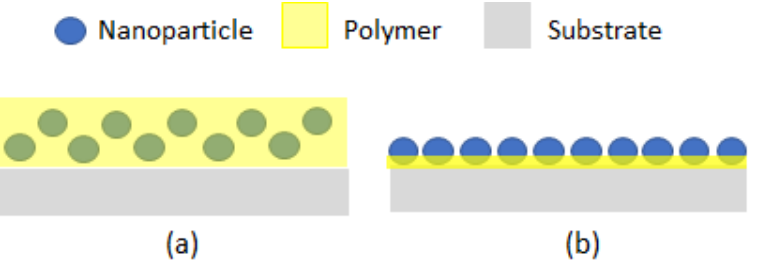
Figure 1. Schematic illustration of nanoparticle integration: ( a ) complete embedment of nanoparticles in the polymer; ( b ) polymer acting as bonding layer between nanoparticles and substrate.